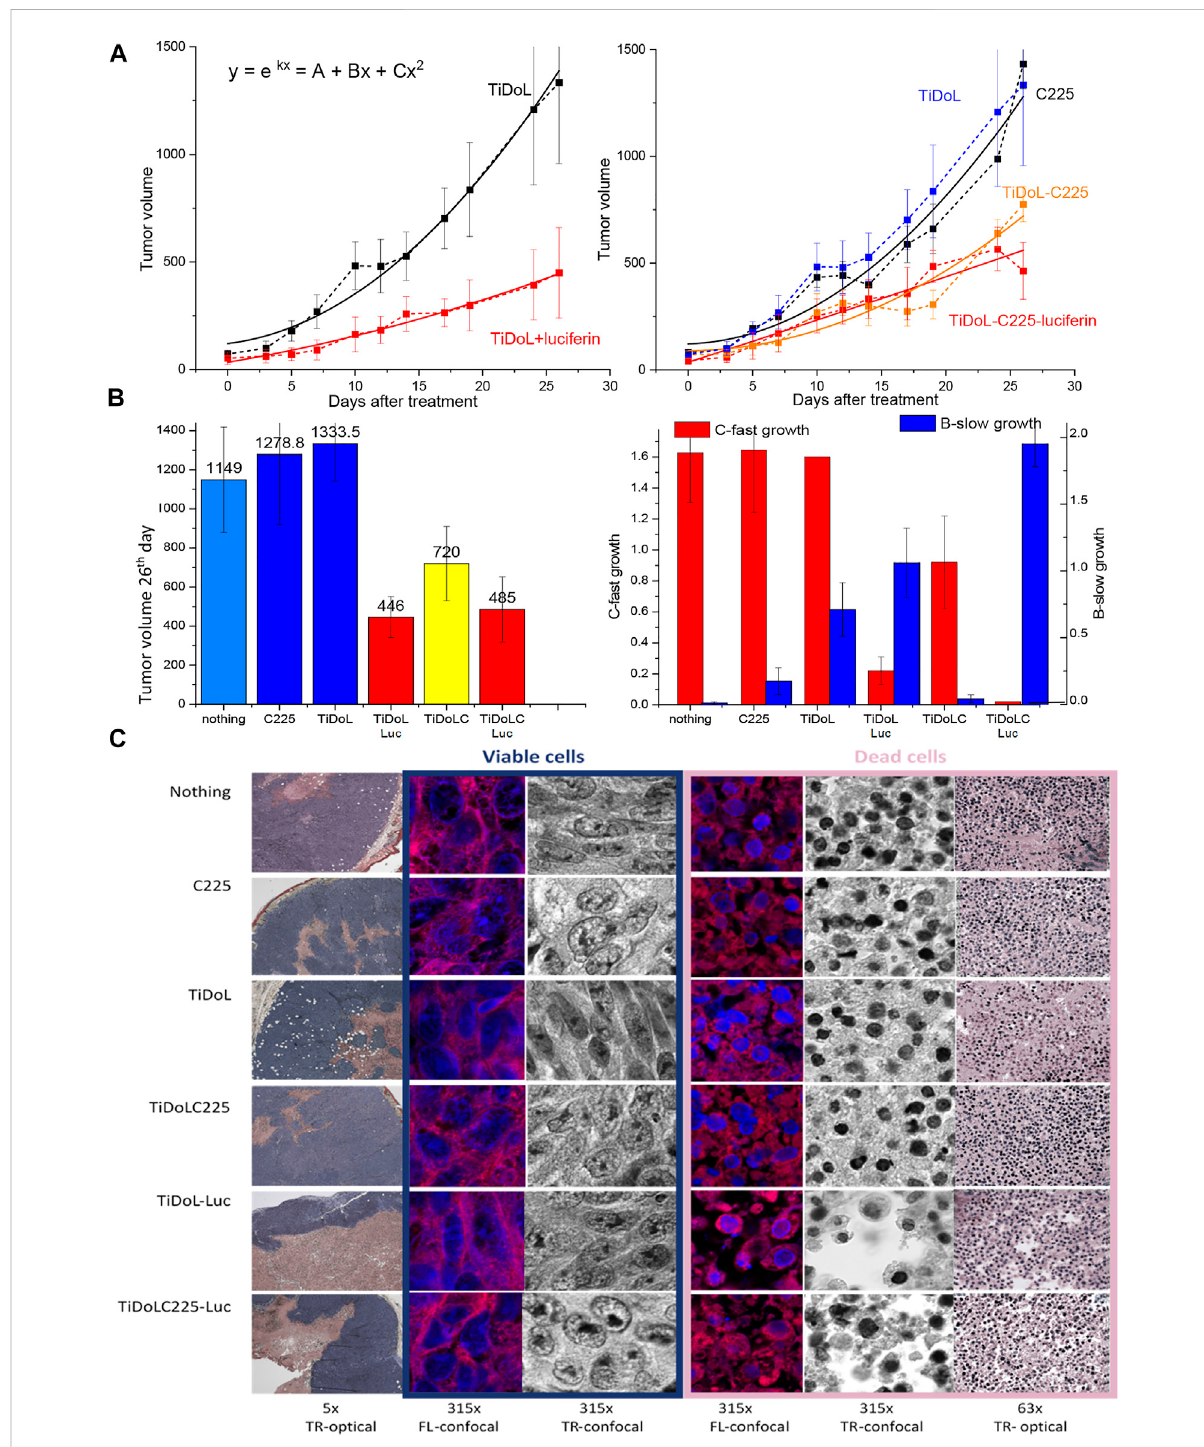
FIGURE 5 In vivo study of tumor growth in nude mice (HCT116 xenografts). (A) Evolution of tumors treated with TiDoL (left) and TiDoLC225 (right) w/o activationwithluciferin.Eachpointisanaverageofsixmeasurements.Statisticalsigni fi cancewasdeterminedusingStudent ’ s t- testas p < 0.0068for TiDoL and p < 0.0083 for TiDoL-C225.Data are fi ttedwith quadratic polynomialdependence as an approximationofexponential growth. (B) Color- coded histogram of tumor sizes 26 days after the treatment of nude mice in conjunction with the histogram of the linear (blue) and quadratic (red) coef fi cient of tumor growth obtained from data fi tting. (C) Transmission optical (TR-optical)and laser confocal fl uorescence (FL-confocal) and optical (TR-confocal) images ofH&E-stained tumor slices obtained bysectioning thetumors 26 days after thetreatmentatdifferentmagni fi